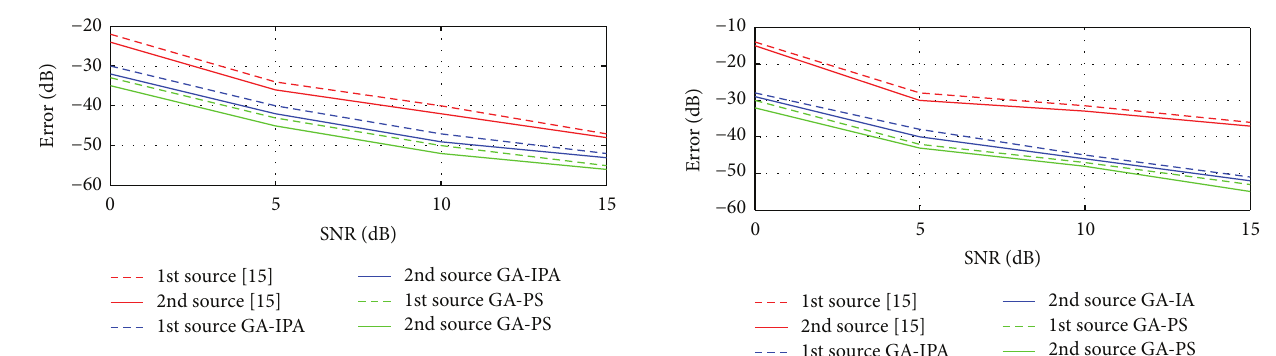
Figure 5: Error estimation of the frequencies versus SNR.